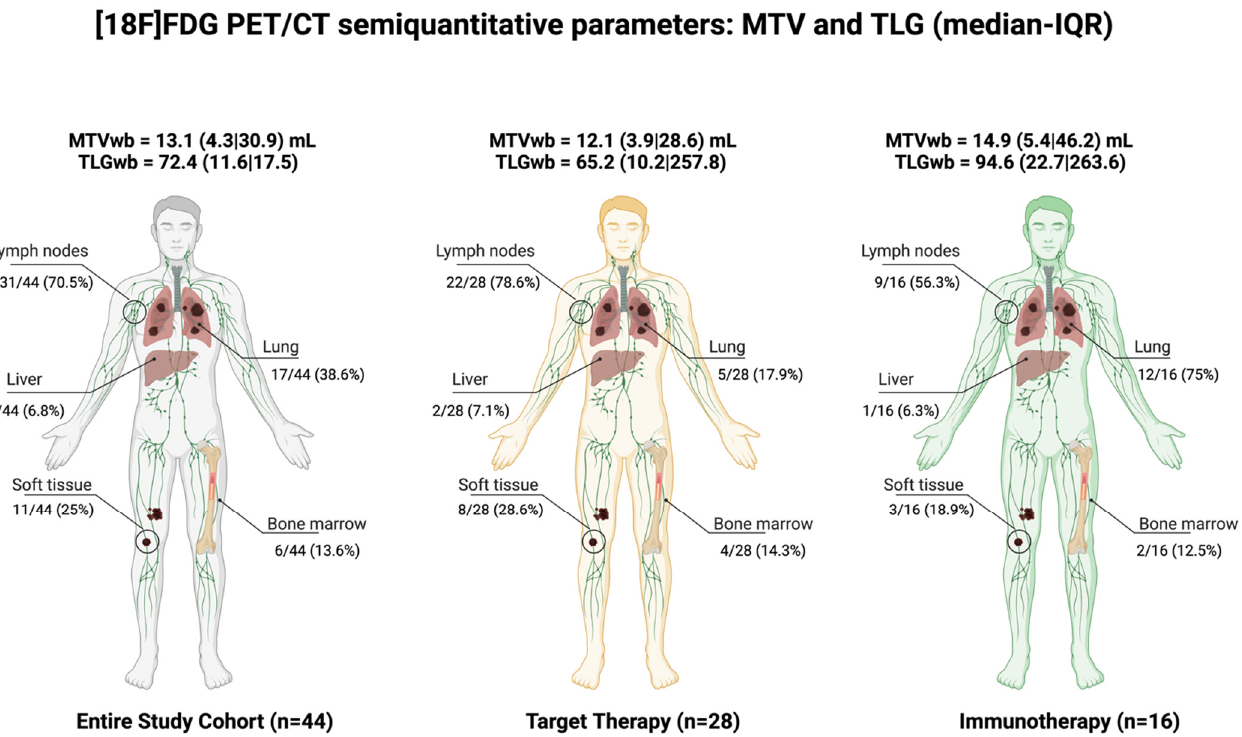
Figure 2. MTV and TLG whole-body and metabolic active lesions per district (interest expressed in percentage) for the entire cohort, the target therapy subgroup, and the immunotherapy subgroup, respectively.